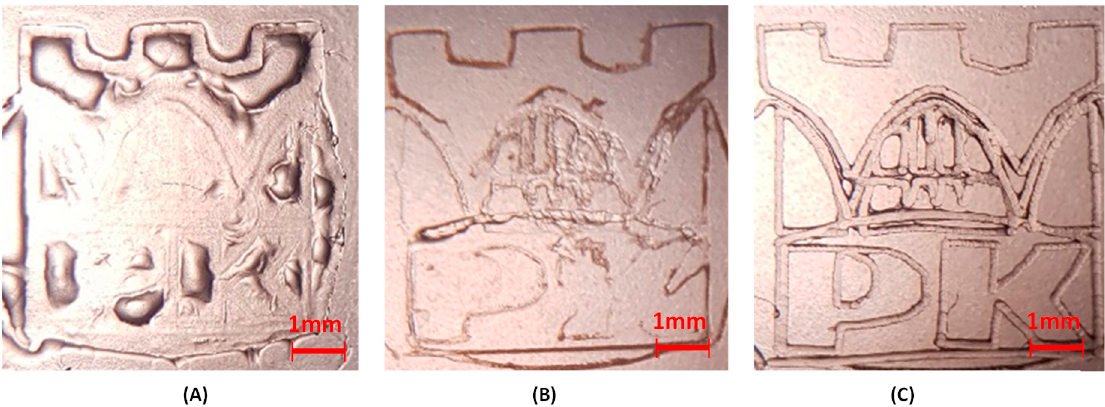
Figure 20. Micrography of the print obtained from cycloaliphatic epoxide monomer (CADE) with a bimolecular photoinitiating system based on; ( A ) DETHX / HIP (0,1% / 1% w / w ), ( B ) S1 / HIP (1% / 1% w / w ), ( C ) S8 / HIP (1% / 1% w / w ).